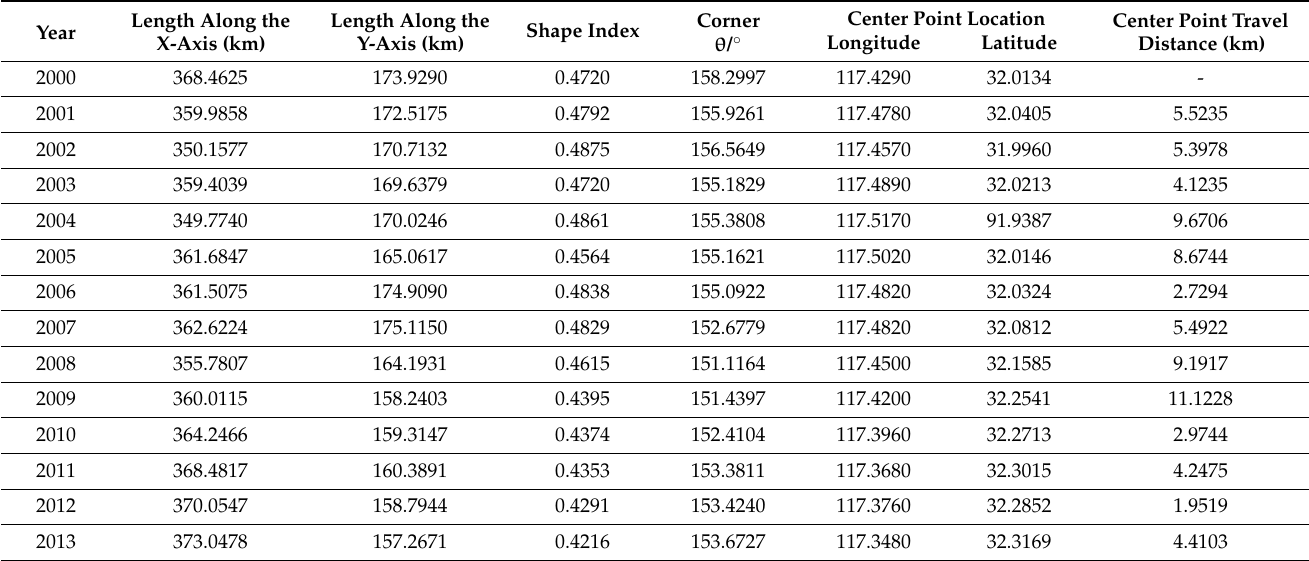
Table 6. Standard deviation ellipse parameters of CEIL in Anhui Province from 2000 to 2013. Length Along the Year X-Axis